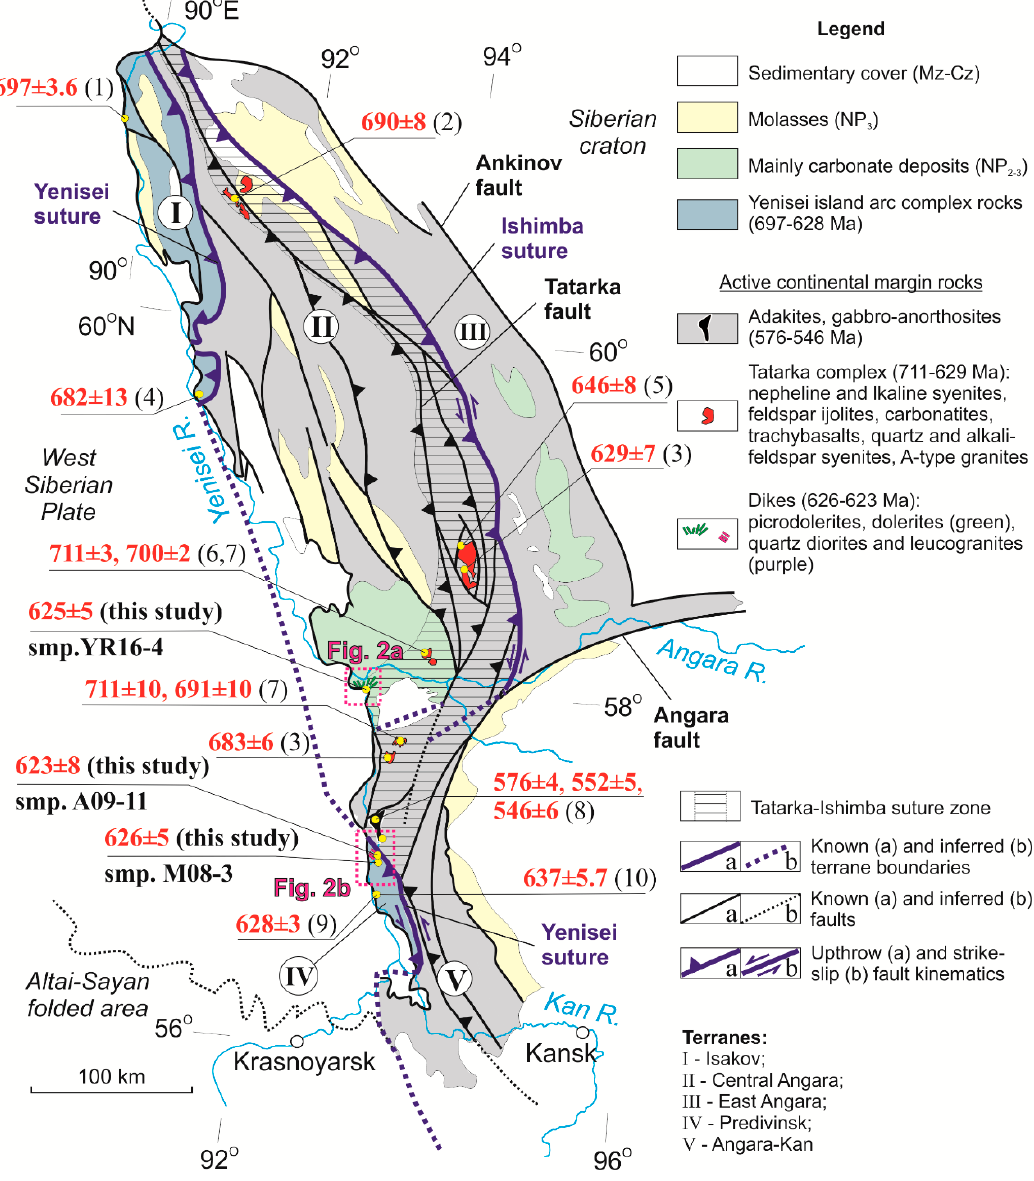
Figure 1. Tectonic scheme of the Yenisei Ridge showing localization and age of manifestations of Ediacaran and Cryogenian igneous rocks, modified after [10,22,24]. Red numbers show ages determined by U-Pb method. Numbers in brackets—reference sources: (1)—[12]; (2)—[16]; (3)—[9,25]; (4)—[13]; (5)—[21]; (6)—[18]; (7)—[26]; (8)—[14]; (9)—[10]; (10)—[11].